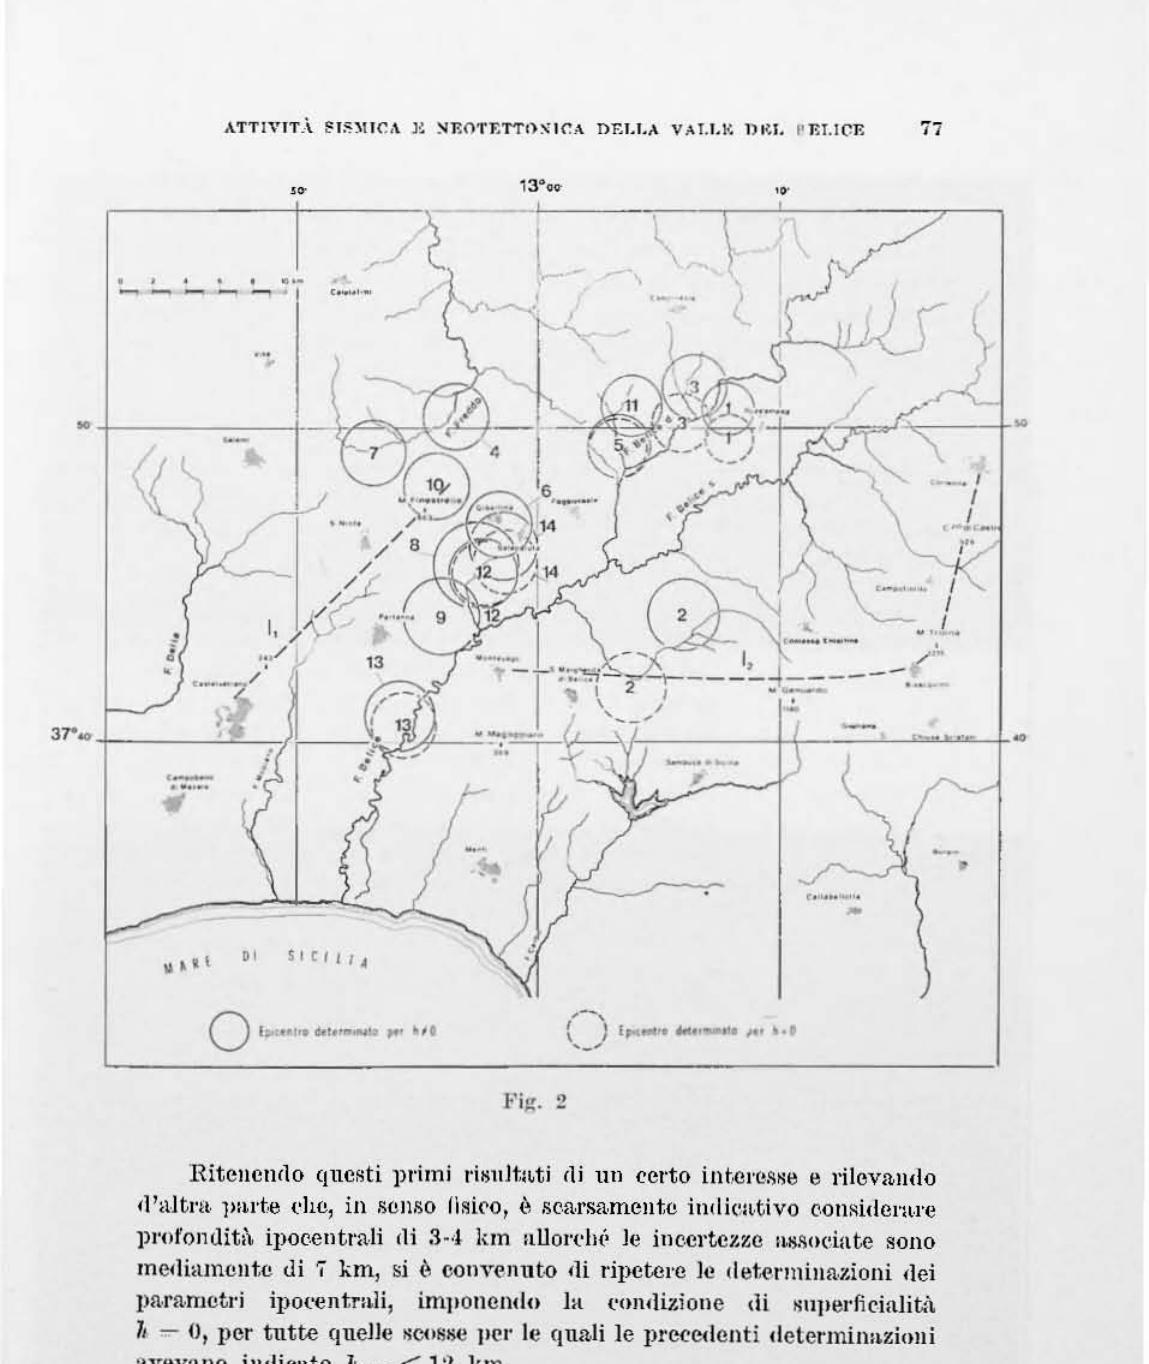
mIHlific:~ apprezzabilmente h. clist.ribuzione e}lic~(mtrl\Je